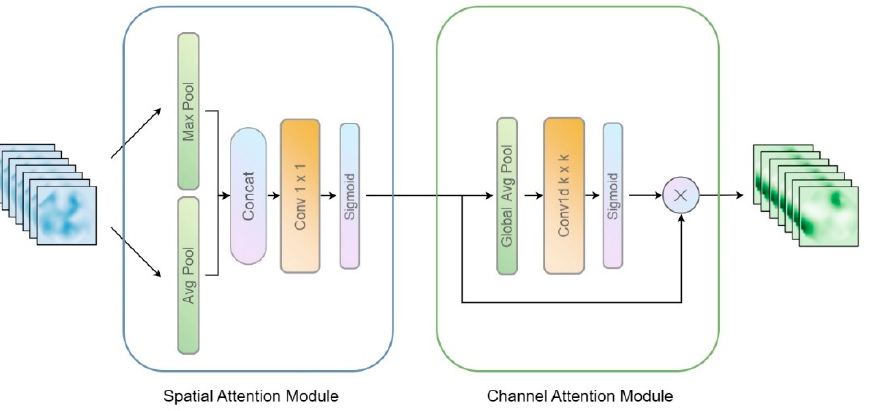
Figure 7. The ESCA module is composed of two parts in series: a spatial attention module and a channel attention module.